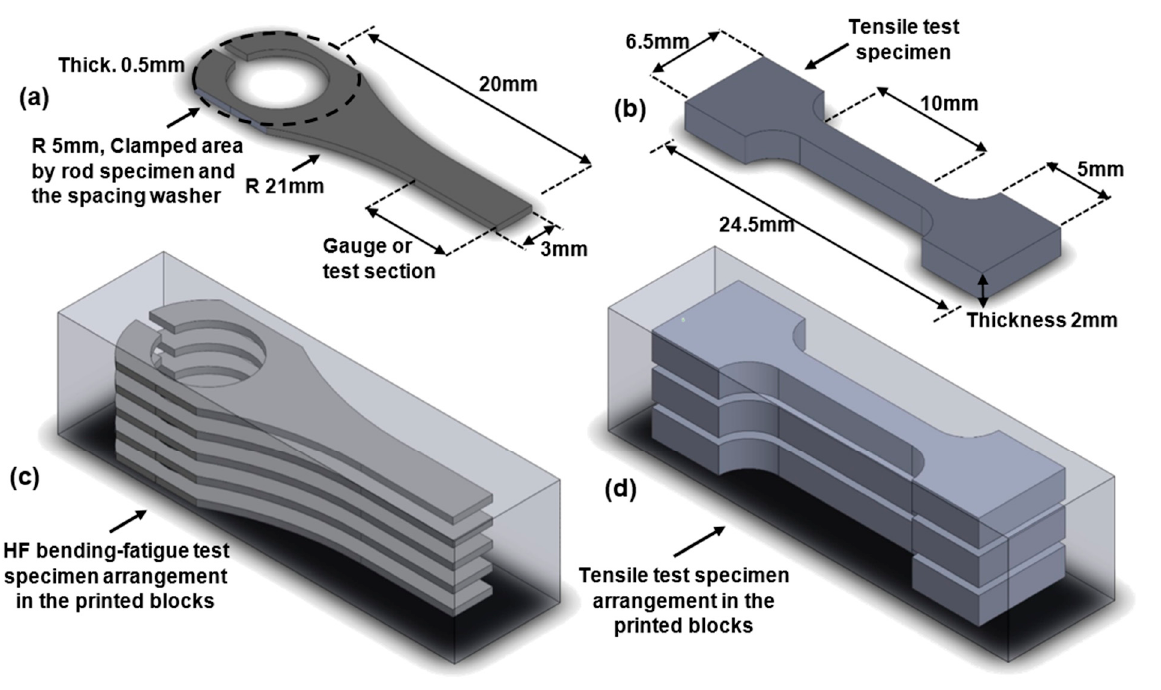
Figure 4. ( c , d ) Tensile/ultrasonic bending fatigue test-specimen arrangement in the printed block. ( a ) High-frequency bending fatigue test specimen’s dimensions. ( b ) Tensile test specimen dimensions.